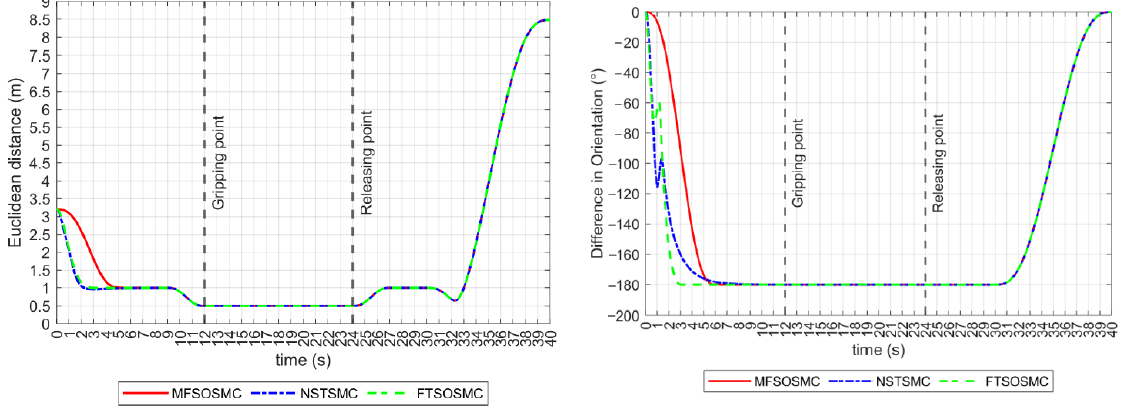
Figure 12. Performance indicators for all the controllers (no external disturbances). Left : Euclidean distance in the 𝑥 axis. Right : relative heading orientation.